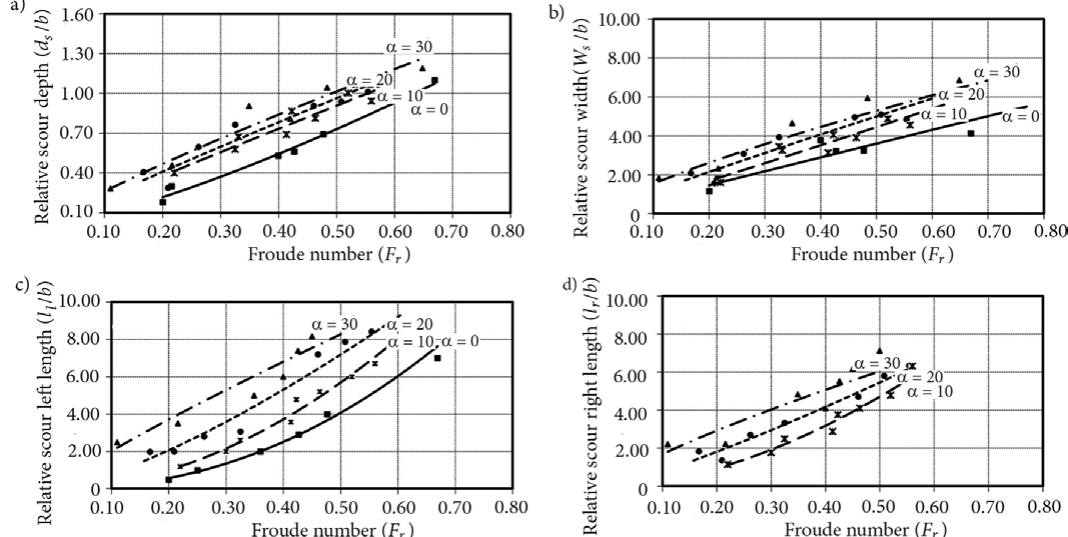
Figure 8. Froude number against relative scour depth, width, left side length and right side length with the varying skew angle